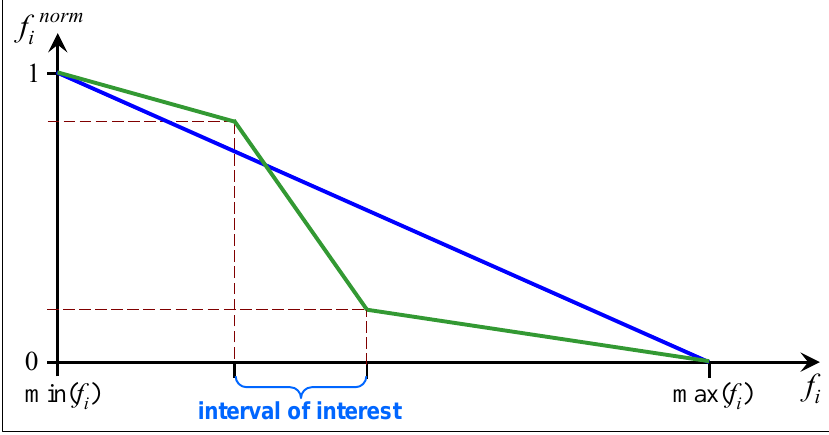
Figure 8. Tuning the normalization of Equation (3) ( blue straight line ) to the interval of interest of one objective f . The decline outside of this interval is reduced drastically to i allow for a strong increase inside, as shown by the green